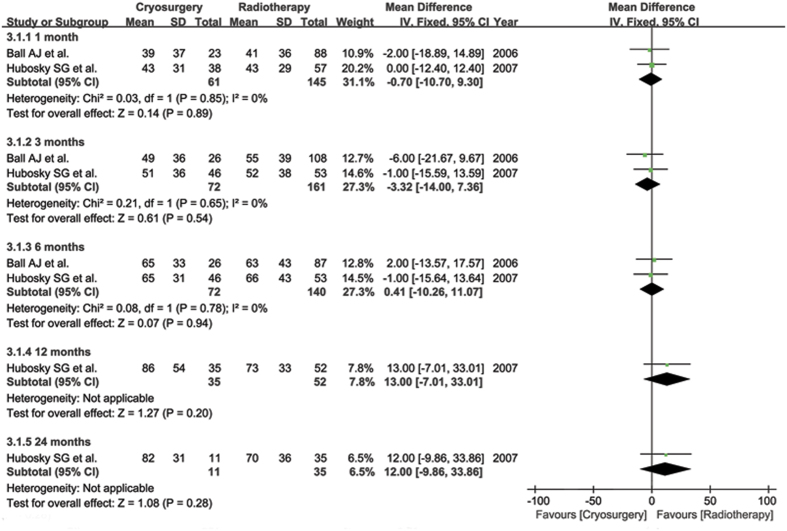
Dynamical forest plot and meta-analysis of University of California Los Angeles, Prostate Cancer Index (UCLA PCI) scores focusing on urinary bother in comparison of CS vs RT in months of 1, 3, 6, 12 and 24, respectively.